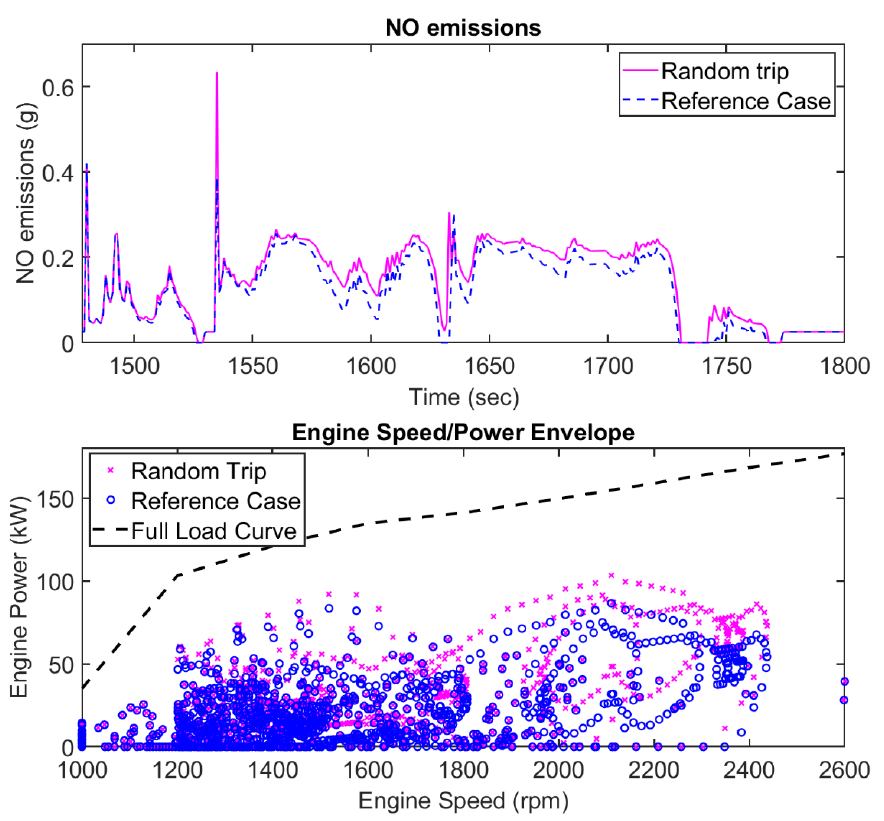
Figure 15. Engine speed/power envelope (WLTC) and corresponding NO emissions (extra-high phase).